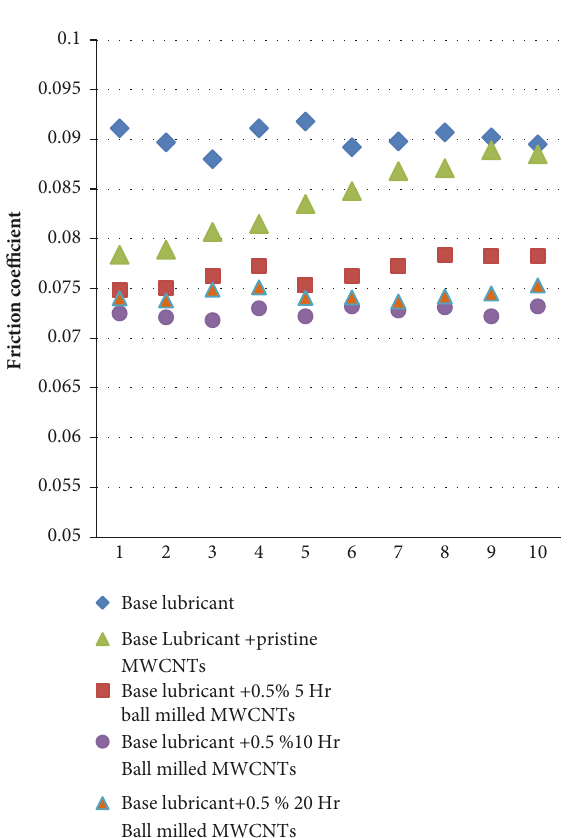
Figure 8: Variation of friction coefficient in 10 repeatable tests carried out during 2